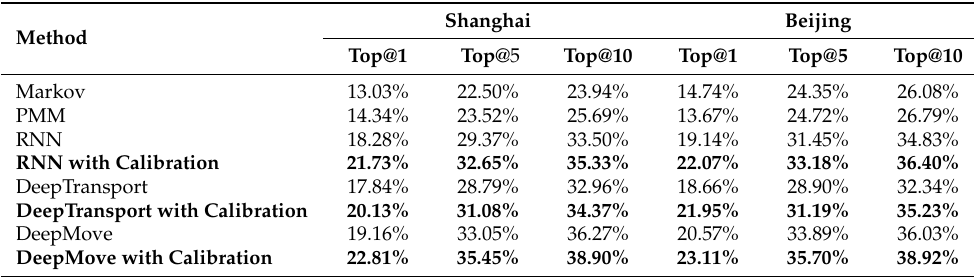
Table 3. Comparison of overall prediction accuracy on datasets in Shanghai and Beijing. Methods combined with our calibration approach are shown in